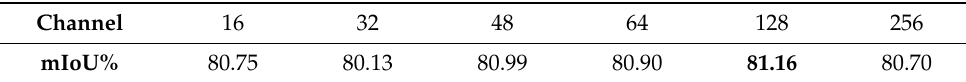
Table 3. Comparison of experimental data on the Cityscapes validation dataset of shape stream with different numbers of output channels.The blackened numbers represent the best performing group in this set of